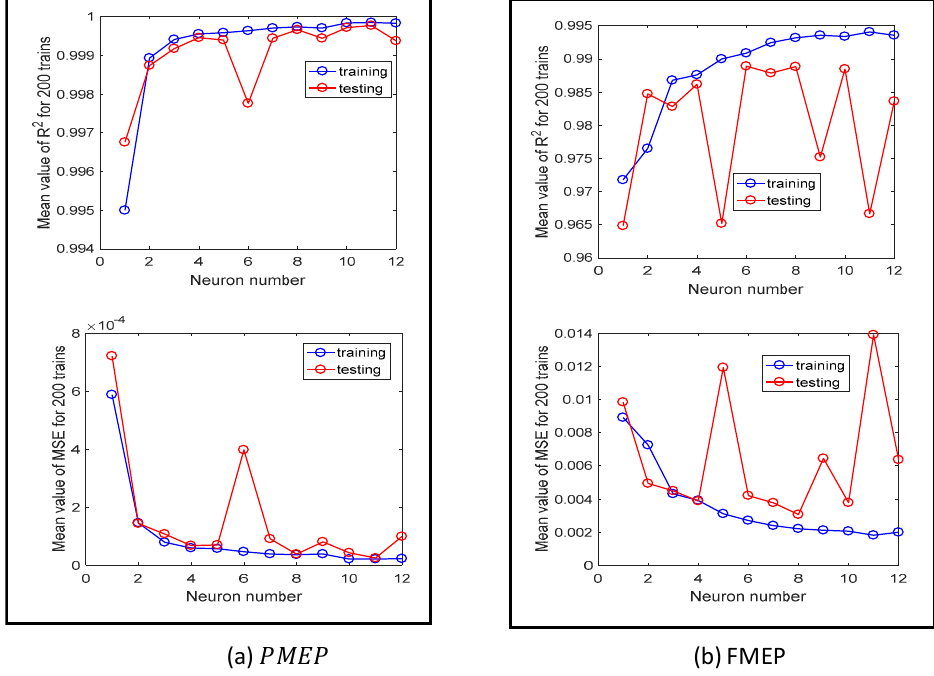
Figure A5. ( a , b ) Mean value of R 2 and MSE over 200 training trials for the ANNs that simulate the different parameters of the physics-based model (BMEP simulation), as a function of the number of neurons.